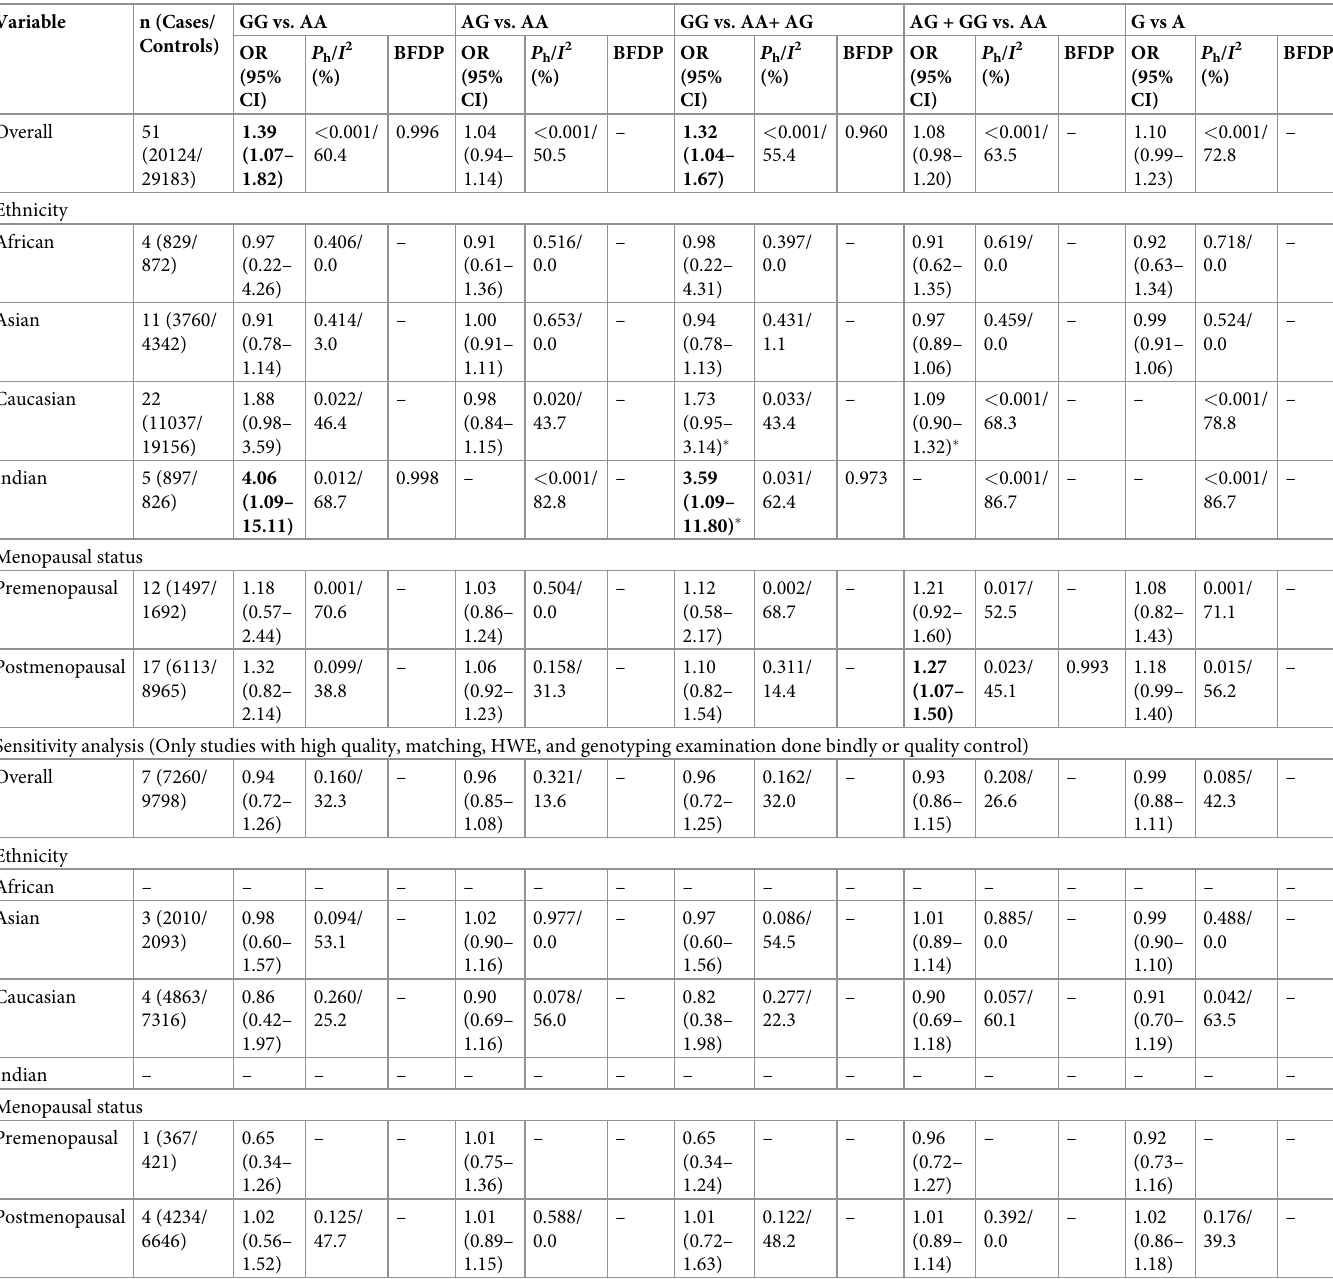
Table 3. Meta-analysis of the association of the CYP1A1 A2455G polymorphism with risk of BC. Variable n (Cases/ GG vs. Controls)